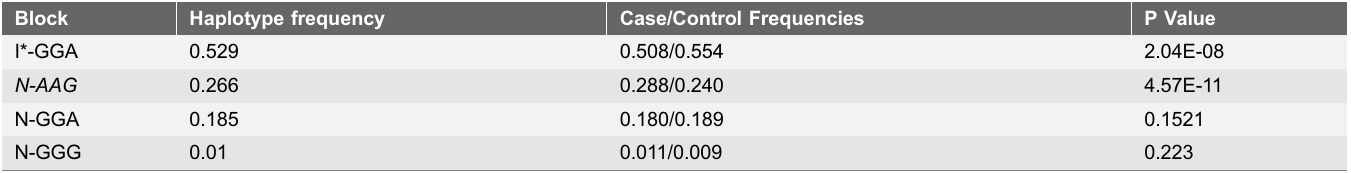
Table 4. The haplotype frequencies of the three known SNPs (rs2736340, rs13277113, rs2618476) and their relation with inversion status.